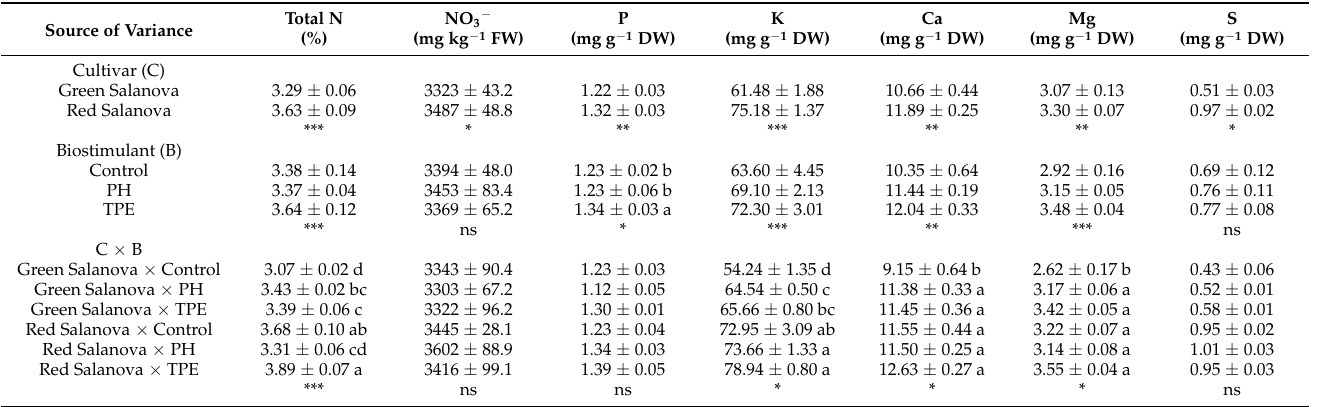
Table 2. Mineral content of red and green salanova lettuce and the influence of biostimulant